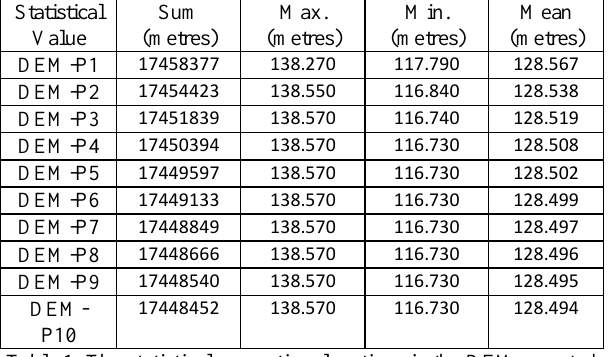
Table 1: The statistical properties elevations in the DEMs created using IDW interpolator with different powers.